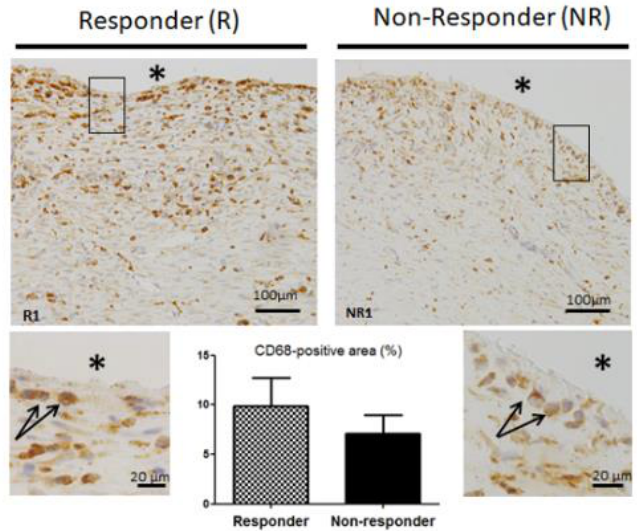
Figure 3. Representative images of CD68 immunohistochemistry. Black star (*) indicates PMMA location before its removal (scale bars 100 µ m). Boxed regions are shown at higher magnification below (scale bars 20 µ m). Black arrows point to CD68-positive cells. Quantitative analysis of the percentage of CD68-positive area was made in three non-overlapping microscopic fields of the induced membranes. Data are expressed as the mean ± SEM.